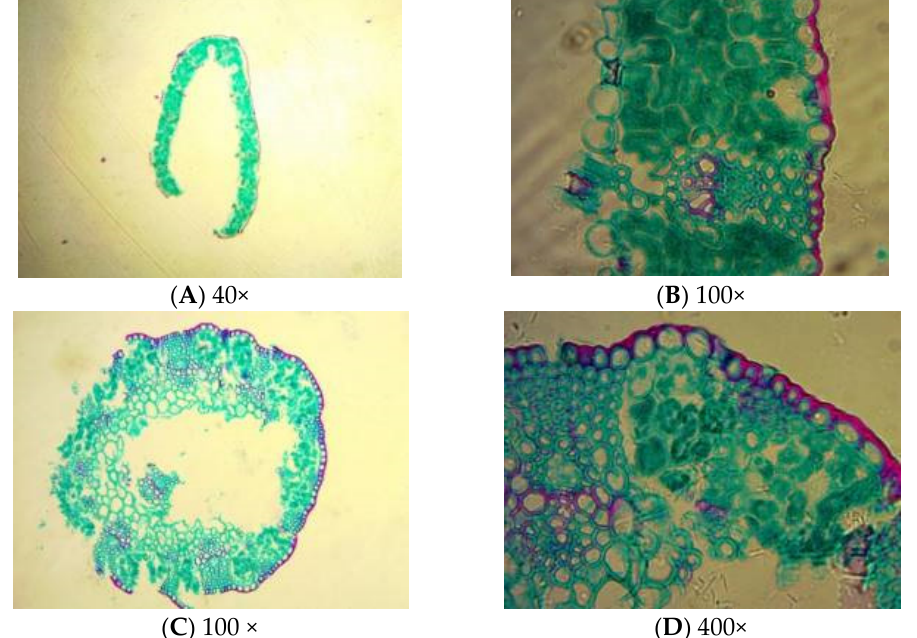
Figure 1. Poa alpigena leaf ( A , B ) and stem ( C , D ) structures. The stems’ epidermal cuticle consisted of one layer of nearly round, uniform epidermal cells that were tightly packed. The individual circular vascular bundles consisted of xylem and phloem. The basic plant tissue consisted of two or three layers of parenchyma cells just below the epidermis. These parenchyma cells are responsible for the plant’s mechanical organization. A medullary cavity was observed in the middle of the stems (Figure